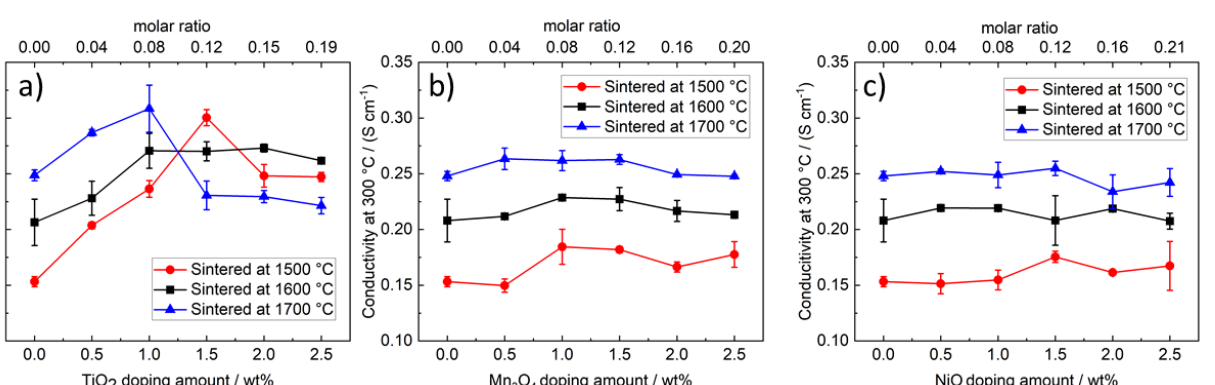
Figure 16. Ionic conductivity at 300 °C of differently doped and sintered Na- β″ -alumina samples. ( a ) TiO 2 -doped Na- β″ -alumina; the results of TiO 2 -doped samples sintered at temperatures of 1500 °C and 1600 °C are reprinted with permission from Dirksen et al. [13] ( b ) Mn 3 O 4 -doped Na - β″ -alumina; ( c ) NiO-doped Na - β″ -alumina.